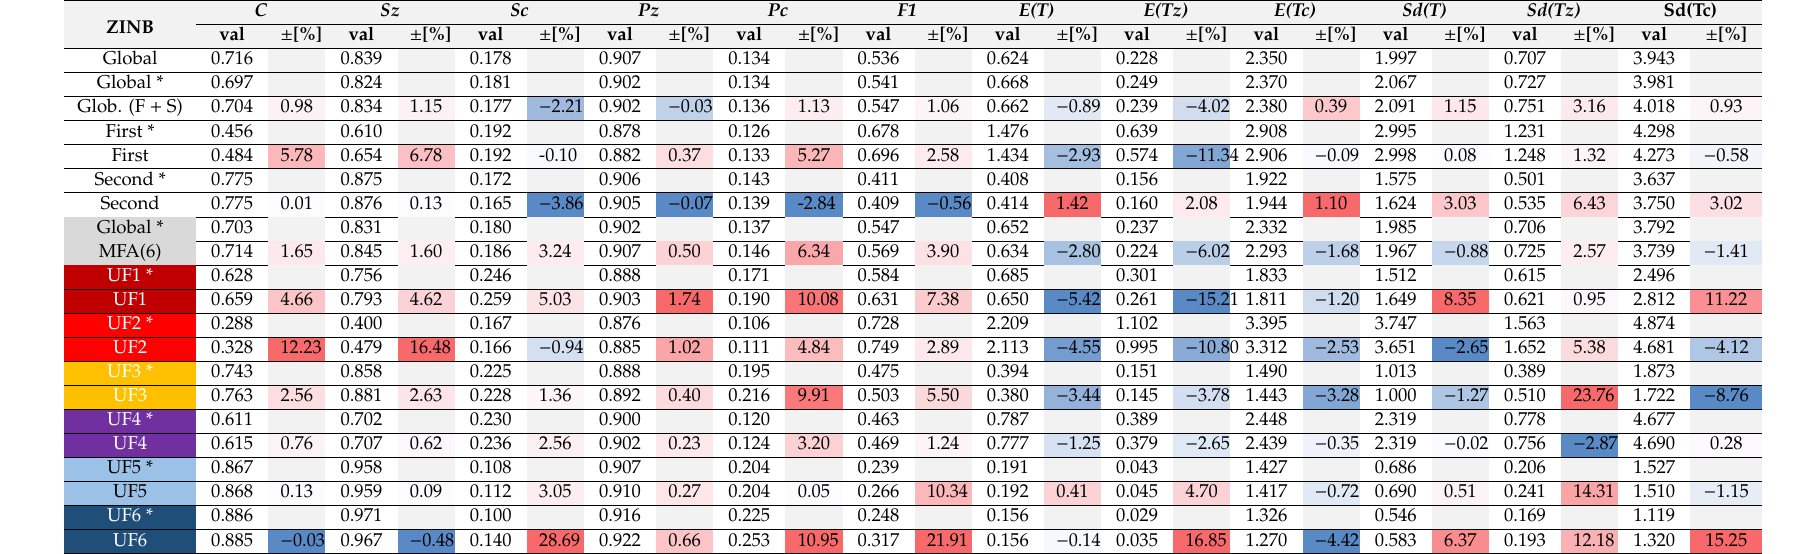
Table 4. Comparison of the results of ZINB models when global and sub-regions are evaluated for the same subgroup of